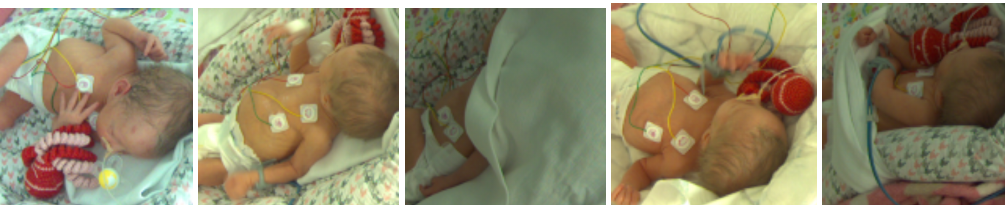
Figure 9. Frames from our challenging test dataset (#1 in Table 2). Conditions depicted from left to right: Heavy motion- twisting the body, swinging arm, covered baby, normal and low light